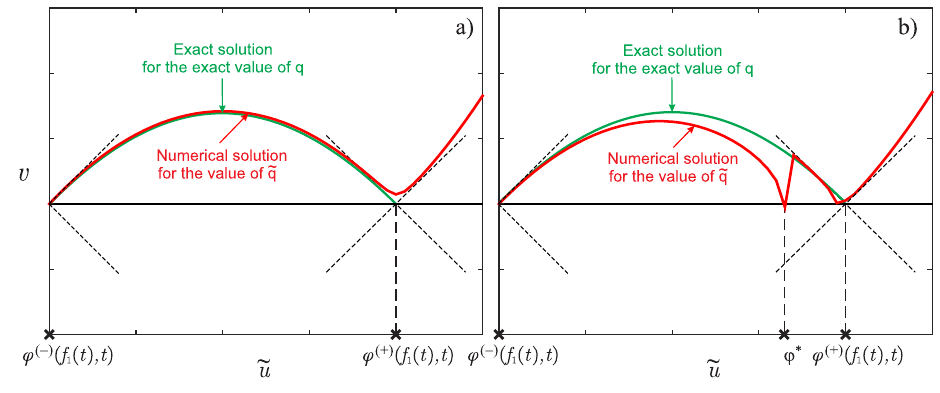
Figure 2. An example of typical solutions to the Cauchy problem (6), obtained numerically for various values of the parameter ˜ q . Pictures correspond to the calculation of an approximate solution v ( 2 S − 1 N ) ( ˜ u ) of the Cauchy problem (6) according to the ERK4 scheme with N = 50 and S = 6 for df = 0.1231, and ( a ) ˜ q = 0.0025, ( b ) ˜ q = 0.09. For both cases, parameters ϕ ( − ) ≡ − 1, ϕ (+) ≡ 1, dt the exact value of q is q =